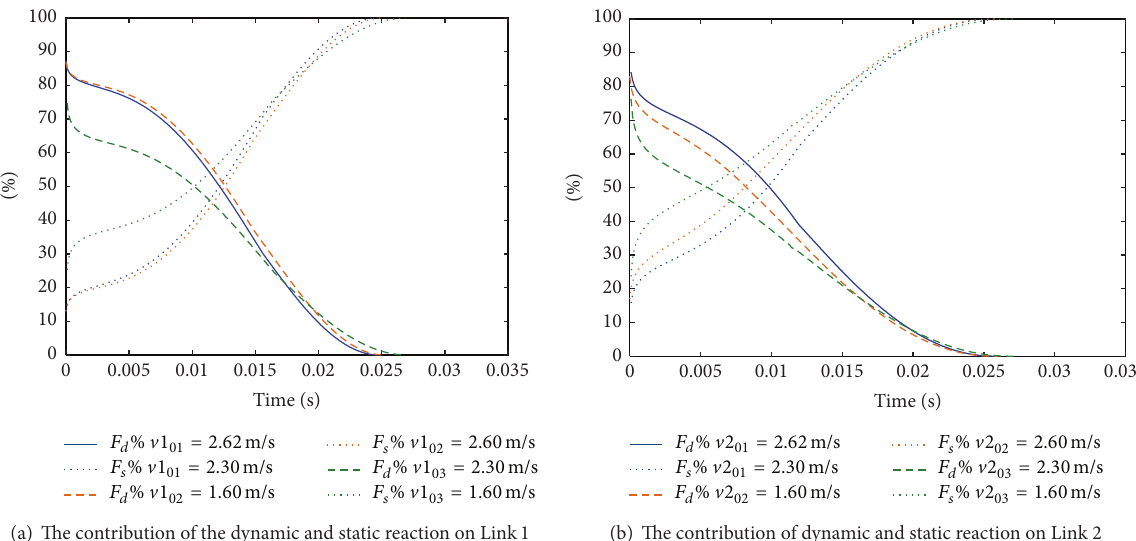
Figure 6: Dynamic and static force percent out of the resistance force for an impact of a two-link kinematic chain with granular matter during the penetration phase: (a) for Link 1 and (b) for Link 2.